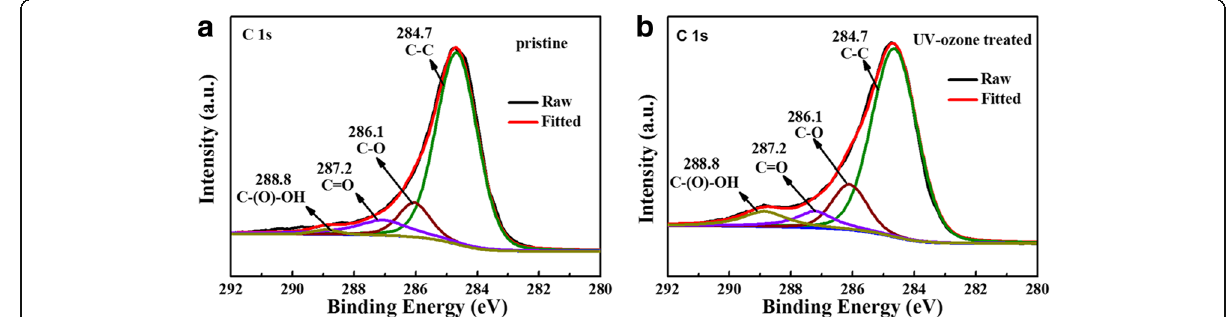
Fig. 2 XPS spectra of a untreated and b UV-ozone-treated